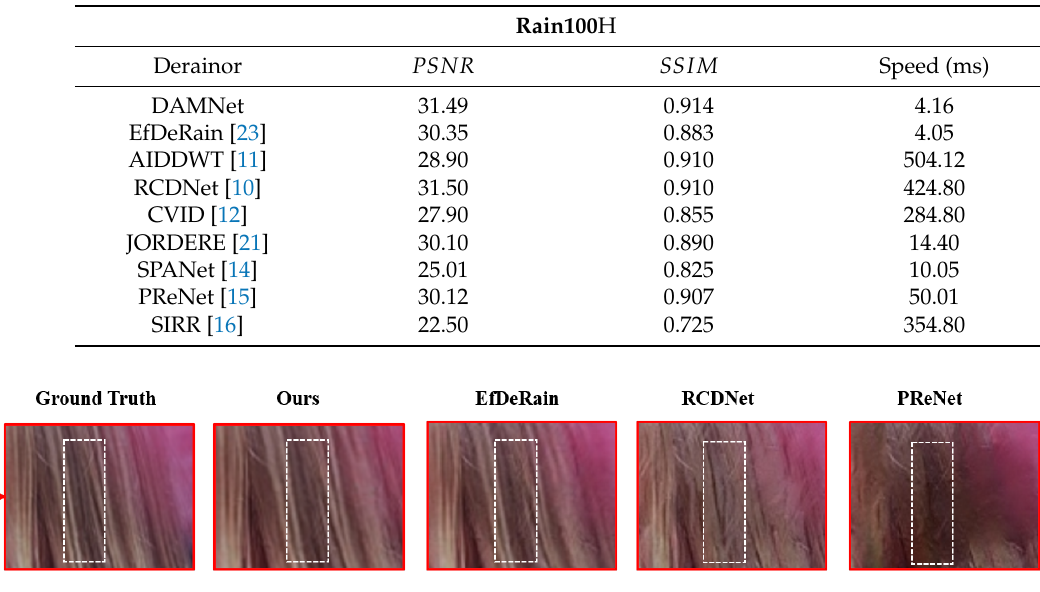
Figure 5. The visualization results on Rain100H. From the preserved details of the face and hair, our model(DAMNet) has impressive performance. In particular, DAMNet maintains more textural details of hair under high-contrast conditions.